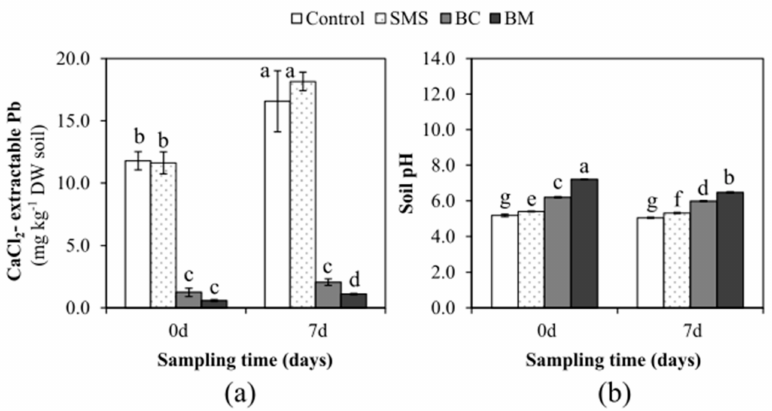
Figure 1. ( a ) CaCl 2 -extractable Pb concentrations and ( b ) pH of control soil and SMS-, BC- and BM-amended soils at 0 and 7 days after amendment application. Error bars represent standard errors. Different lower case letters above error bars indicate significant differences at p < 0.05 among means of different